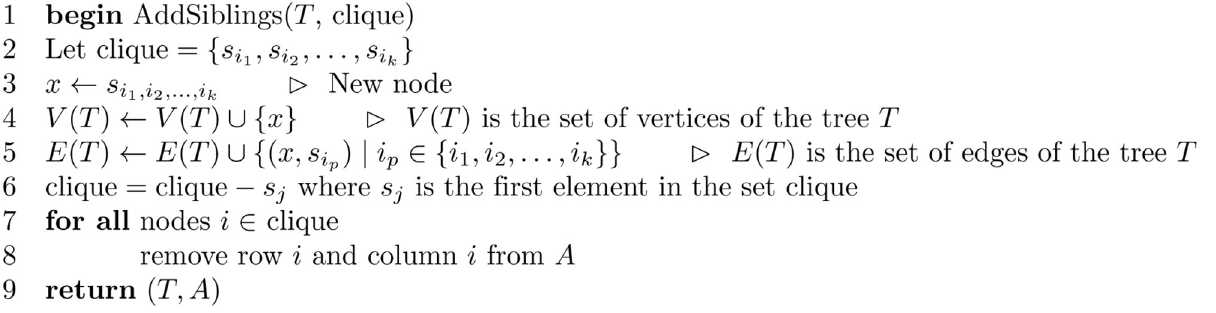
Fig 21. Algorithm to add elements of a clique as siblings in a tree T .